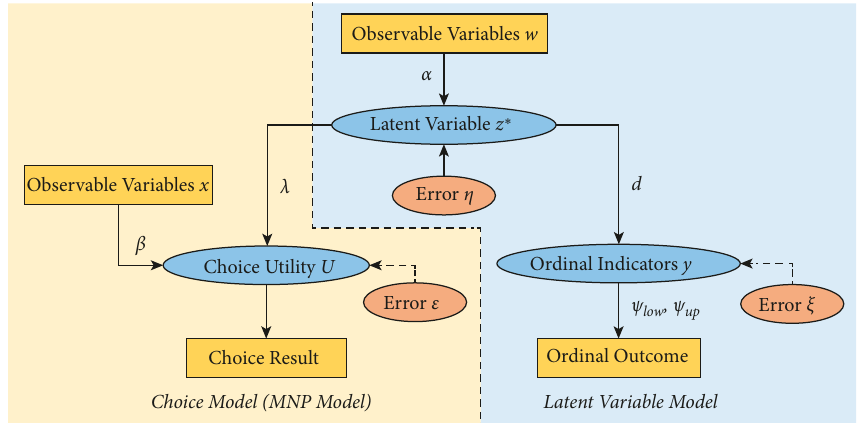
Figure 1: MNP-based ICLV model